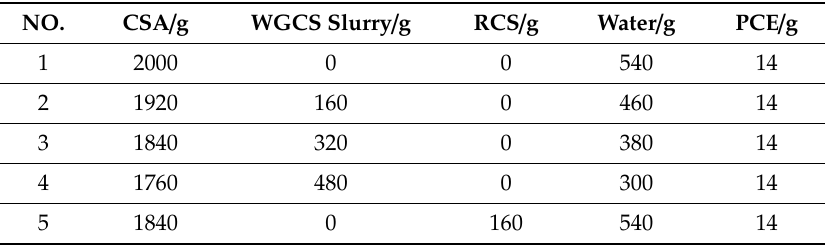
Table 3. Mix designs of pastes.